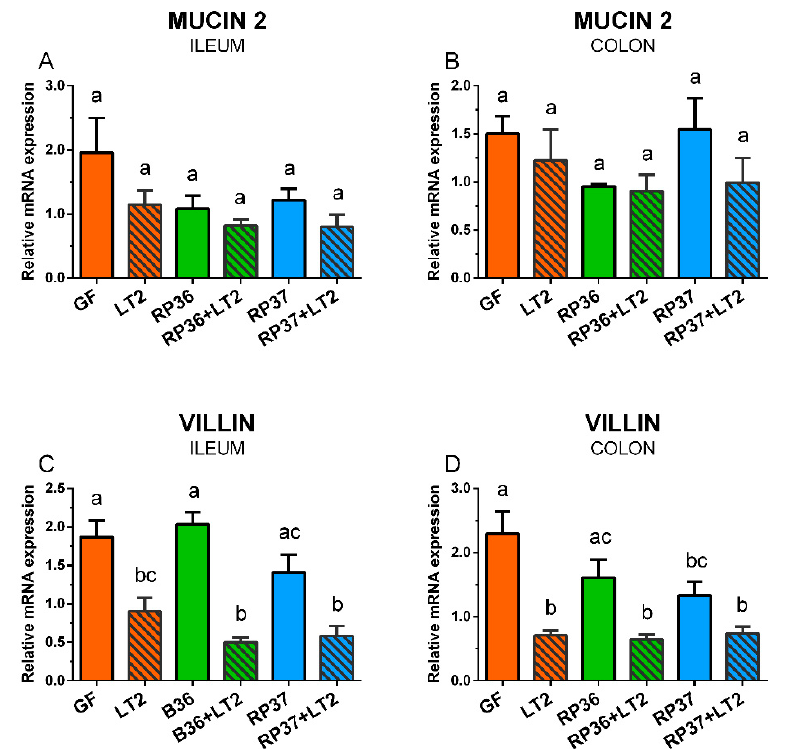
Figure 6. Expression of mucin 2 ( A , B ) and villin ( C , D ) mRNA in the ileum ( A , C ) and colon ( B , D ) of the gnotobiotic piglets: Germ-free (GF), infected with S . Typhimurium LT2 (LT2), colonized with B. boum RP36 (RP36), colonized with RP36 and infected with LT2 (RP36 + LT2), colonized with B. boum RP37 (RP37), and colonized with RP37 and infected with LT2 (RP37 + LT2). The values are presented as mean + SEM. Statistical di ff erences were calculated by one-way ANOVA with Tukey’s multiple comparison post-hoc test, and p -values < 0.05 are denoted with di ff erent letters above the columns. Six samples in each group were analyzed.